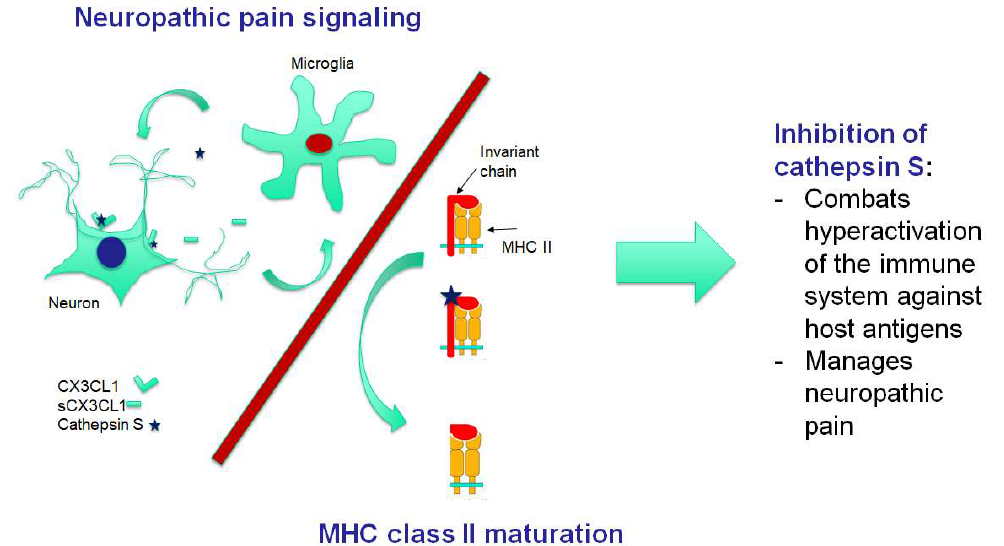
Figure 1. Inhibition of cathepsin S: the mechanism of potential bifunctional therapeutic approach in fibromyalgia. Cathepsin S is involved both in central sensitization, which underlies neuropathic central pain, and in the mediation of the immune response. Activated microglial cells release cathepsin S, which then cleaves CX3CL1 from neurons; this soluble form of the chemokine is active in the stimulation of microglia (positive feedback). Chemokines and cytokines released by activated microglia produce a state of neuronal hyperactivity (central sensitization). In immune cells, cathepsin S cleaves off the invariant chain, which forms a complex with nonmature MHC II molecules in the endoplasmic reticulum and hence blocks the binding of cellular peptides or peptides from the endogenous pathways. Inhibition of cathepsin S blocks the processing of the invariant chain, thereby halting MHC II maturation in the Golgi apparatus before the fusion with a late endosome. Some promising results of cathepsin S inhibition, both in autoimmune diseases and in chronic pain syndrome, are described in the text. The soluble form of CX3CL1 was significantly elevated both in cerebrospinal fluid and the plasma of patients with fibromyalgia. There is additional evidence of neuroinflammation in FM. Widespread activation of microglia (most pronounced in the medial and lateral walls of the frontal and parietal lobes) was detected by positron emission tomography in the cortex of patients with FM compared to healthy controls [41]. Higher subjective ratings of fatigue in FM patients were associated with a higher signal in the anterior and posterior middle cingulate cortices. Neuroinflammation in FM was interpreted both as “neurogenic,” presumably triggered by pain and stress [42], and secondary to such concomitant conditions of FM as small intestine bacterial overgrowth (a type of gastrointestinal dysbiosis), vitamin D deficiency, and mitochondrial dysfunction [43]. Notably, all of those concomitant conditions are linked with autoimmunity: small intestine bacterial overgrowth and vitamin D deficiency are considered factors predisposing to some autoimmune diseases [44], and mitochondrial dysfunction is discussed as the consequence of these diseases. In particular, small intestine bacterial overgrowth was associated with inflammatory bowel disease, Sjogren’s syndrome, celiac disease resistant to a gluten-free diet, and seropositivity for anti-TPO AAb [45–48]. Vitamin D was shown to modulate multiple sclerosis, systemic sclerosis, autoimmune thyroid diseases, rheumatoid arthritis, and primary biliary cirrhosis [49]. Localized or global mitochondrial dysfunction is currently considered an invariant feature of autoimmune diseases and was reported in multiple sclerosis, systemic lupus erythematosus, Sjogren’s syndrome, and rheumatoid arthritis [50]. However, irrespective of the origin of neuroinflammation in FM, it “opens the gate” for immune cells and AAb to the brain [51]. In this case, one could suggest the pathophysiological relevance of AAb to 5-hydroxytryptamine in FM (see above), which is characterized by low-serum serotonin levels and a constellation of